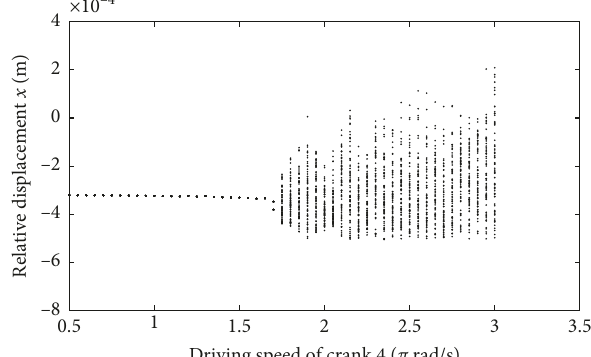
� − π ( rad / s ) , ω 1 � 2 . 5 π ( rad / s ) 4